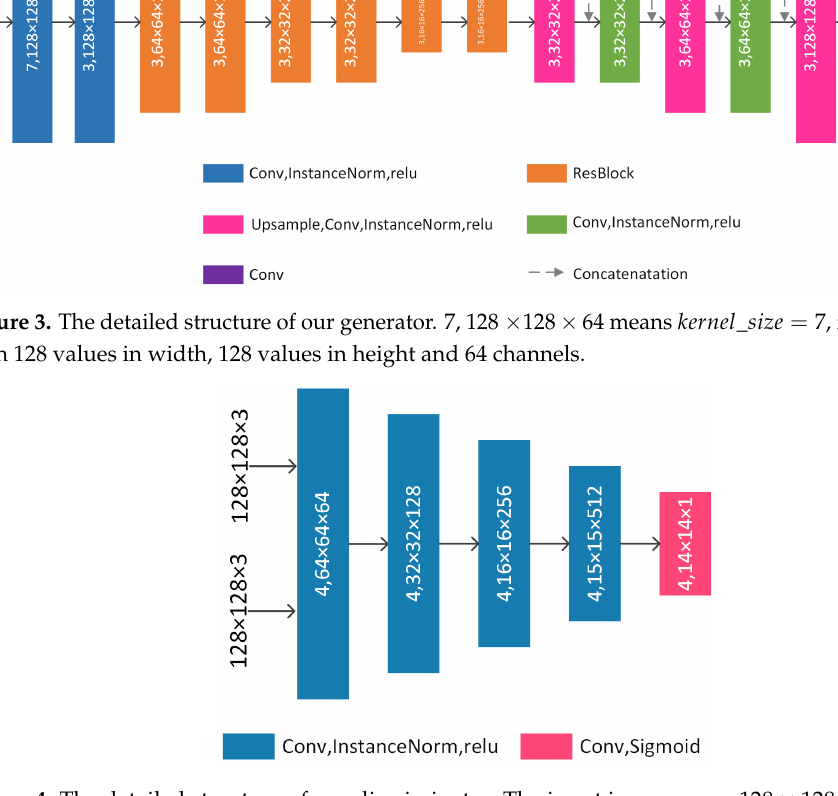
Figure 4. The detailed structure of our discriminator. The input images are a 128 × 128 paired color images such as ( x , y ) and ( x , G ( x )) . 4, 64 × 64 × 64 means kernel _ size = 4, feature maps with 64 values in width, 64 values in height and 64